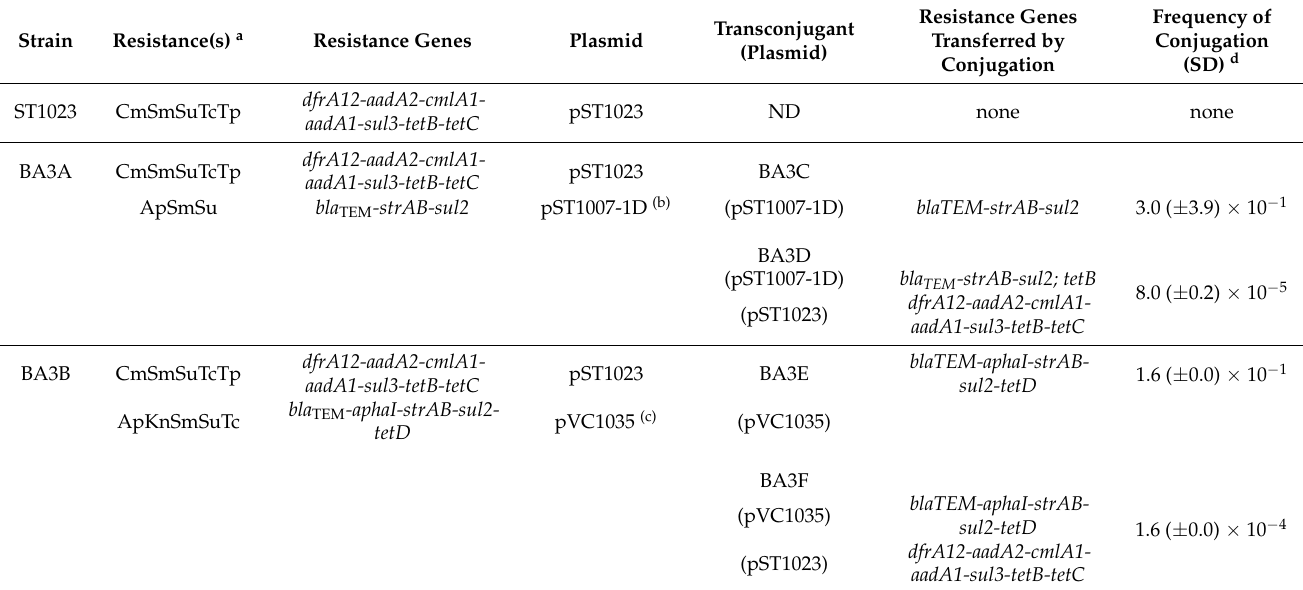
Table 1. Conjugation experiments and mobilisation of